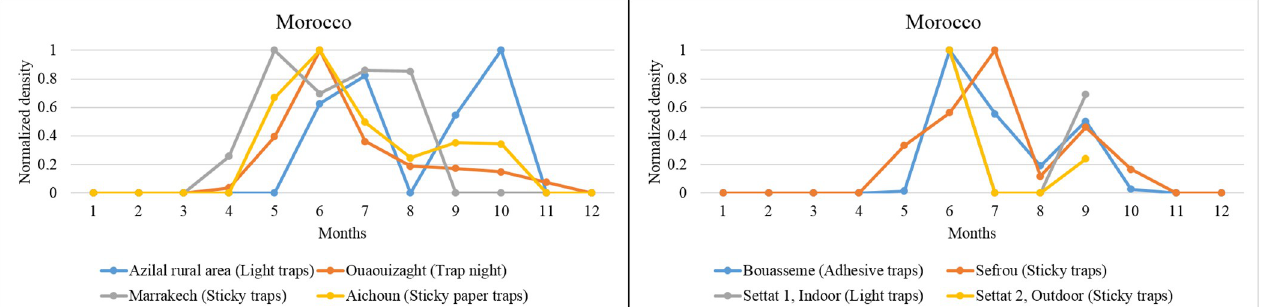
Fig 5. Seasonal P . (Par . ) sergenti density (normalized values) extracted for Morocco, North Africa, as revealed by our meta-analysis. Data collected from different studies performed in the same locality are grouped in the same figure. Asia, western Asia. Turkey’s bimodal sand fly density distributions are recorded (Figs 3 and 6 and Table 1). In the Curkova area, two series of data collected in 2007 and from 2011 to 2012 were extracted from the literature. Both display a bimodal distribution of P . (Par . ) sergenti density, with maximum peaks occurring in June, July, and September.